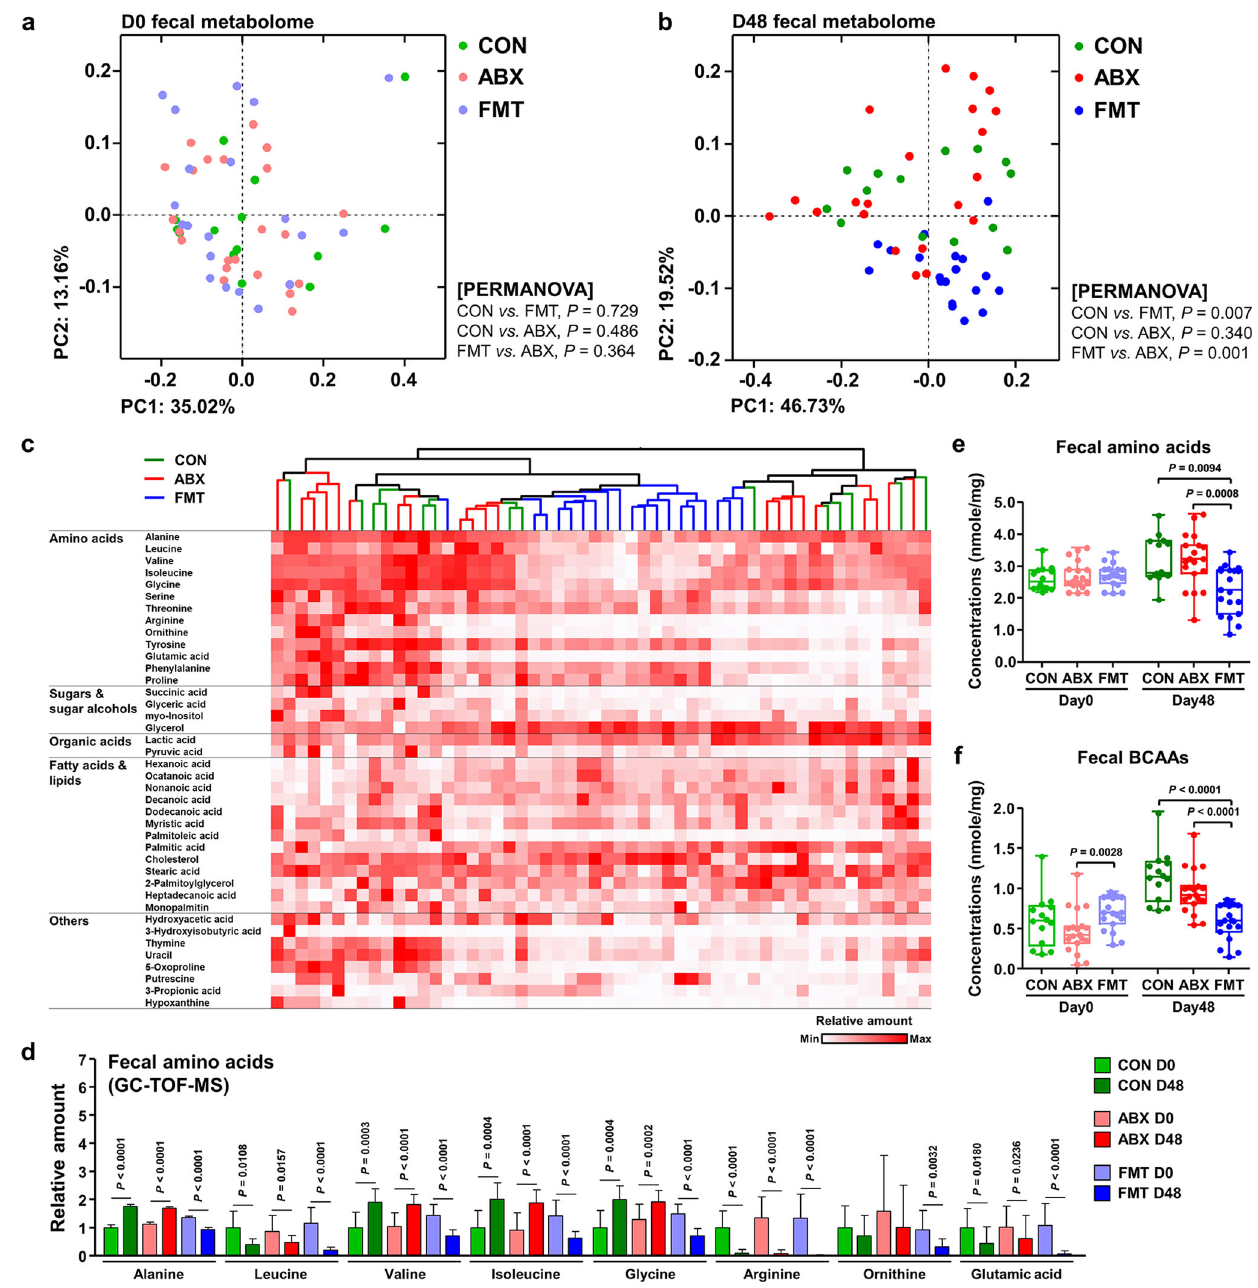
Fig. 4 Changes in the fecal metabolome pro fi le of the diarrheic calves following FMT. The metabolomes of the calves were analyzed using GC-TOF-MS and clustered using PCoA, based on the Bray – Curtis dissimilarity matrix. a The fecal metabolome pro fi les of calves before (day 0, n = 54) and b after (day 48, n = 54) treatment. The metabolome pro fi les for the CON, ABX, and FMT groups are shown in the same colors. The data were analyzed using PERMANOVA, with 999 permutations. c The abundant metabolites in day 48 samples were clustered using a UPGMA dendrogram, based on the Bray – Curtis dissimilarity matrix, and the relative abundances are represented in a heatmap. Samples from the same groups are shown in the same color. d The relative quantities of rectal metabolites are displayed as bar charts and dot plots (day 0, n = 54; day 48, n = 54). e Amino acid concentrations in the fecal samples obtained from calves in each group on days 0 ( n = 54) and 48 ( n = 54). The amino acid concentrations were measured by an enzymatic method using an L -amino acid quantitation kit, and are displayed as box and dot plots. The lines, boxes, and whiskers in the box plots represent the median, and 25th, and 75th percentiles, and the min-to-max distribution of replicate values, respectively. f The branched-chain amino acid (BCAA) concentrations in the fecal samples obtained from calves at days 0 ( n = 54) and 48 ( n = 54). The concentrations of the BCAAs are displayed as box and dot plots. The lines, boxes, and whiskers in the box plots represent the median, and 25th, and 75th percentiles, and the min-to-max distribution of replicate values, respectively. Data are shown as mean ± SEM and were analyzed using the Mann – Whitney U test (two-tailed). CON control, ABX antibiotic, FMT fecal microbiota transplantation, BCAAs branched-chain amino acids. Source data are provided as a Source Data fi le.